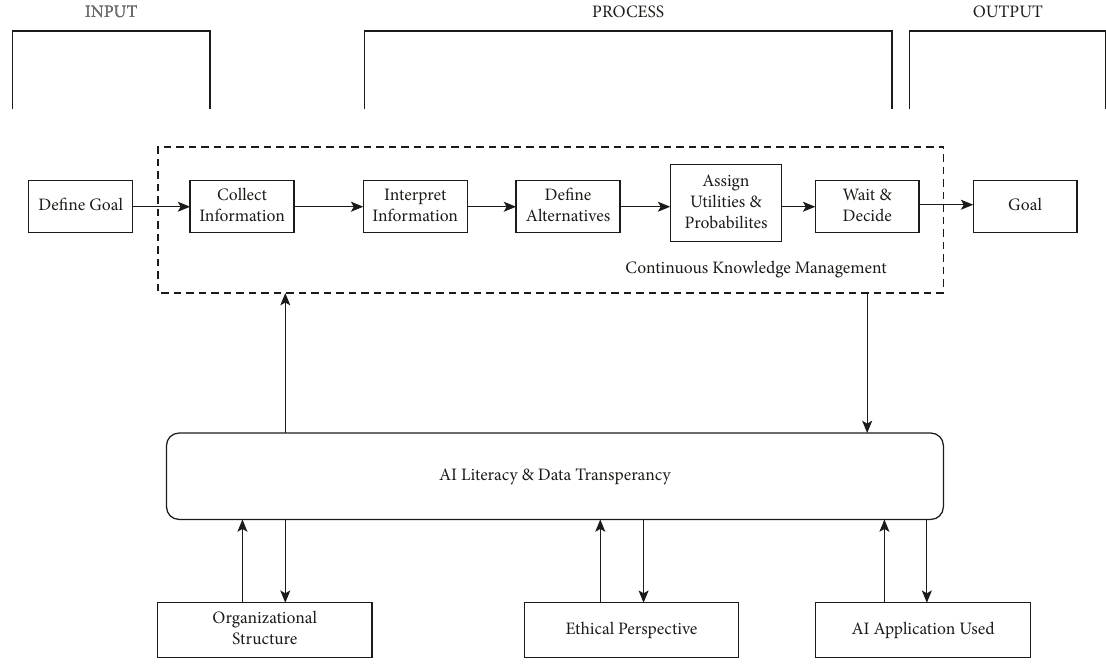
Figure 8: Conceptual model for